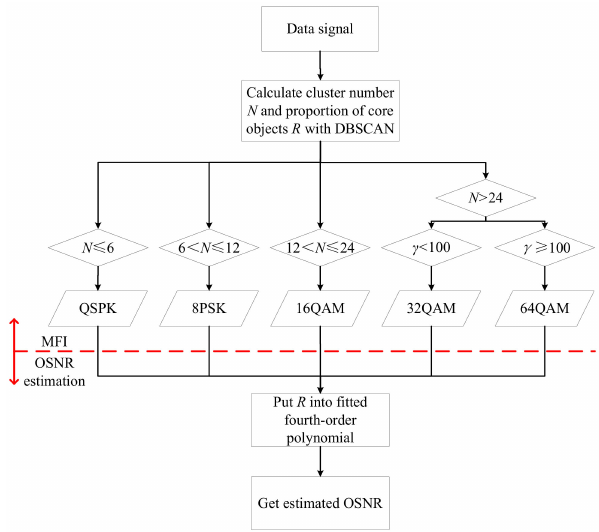
Figure 5. The flowchart of DBSCAN based MFI and OSNR estimation joint